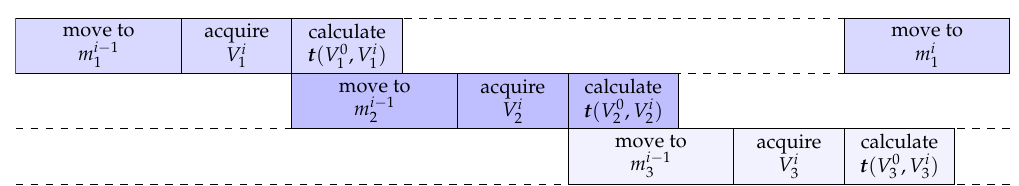
Figure 4. Sketch of pipelined multi-template tracking with three templates. Iteratively, a new volume is acquired and evaluated to determine the motor position for this template in the next iteration. Note that calculating the translations typically is faster than moving to the next position for